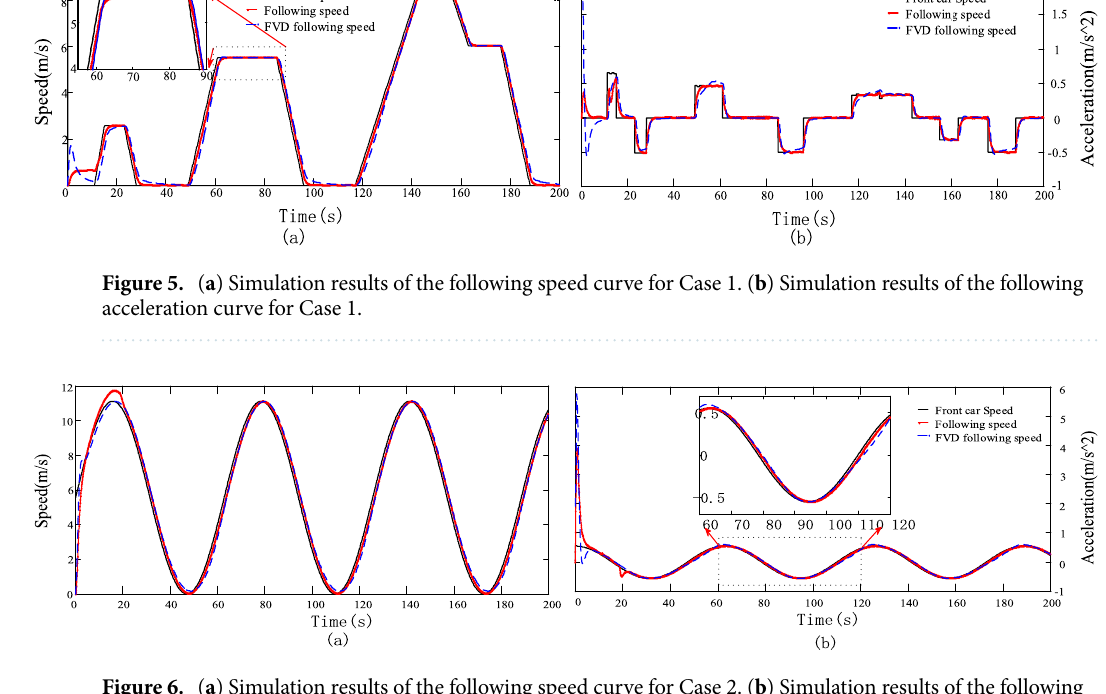
Figure 6. ( a ) Simulation results of the following speed curve for Case 2. ( b ) Simulation results of the following acceleration curve for Case